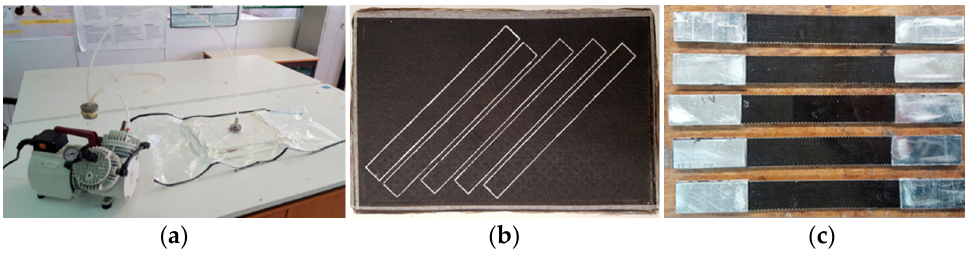
Figure 8. Manufacturing of the basalt fibers (BFRP) composites specimens: ( a ) vacuum bagging, ( b ) cut marks of [ ± 45] specimens, and ( c ) final specimens. Table 4. Physical and Mechanical Properties of the basalt fibers (BFRP) composite.